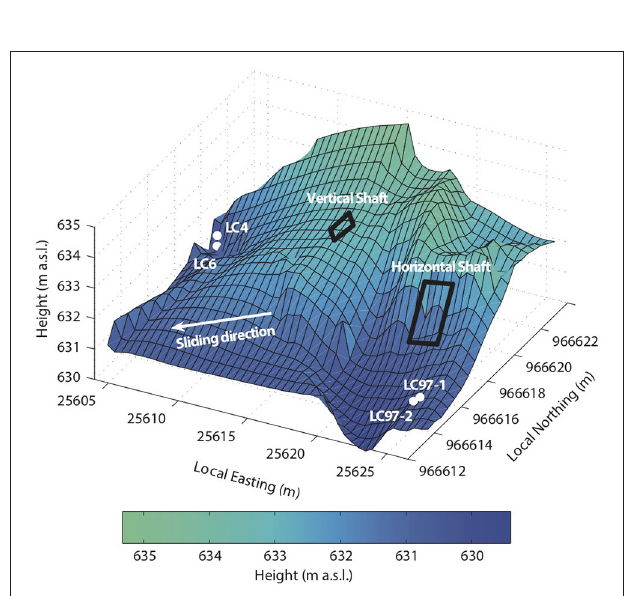
FIGURE 2 | Map of the bed topography near the research shafts and location of the load cells, adapted from Lappegard et al. (2006).